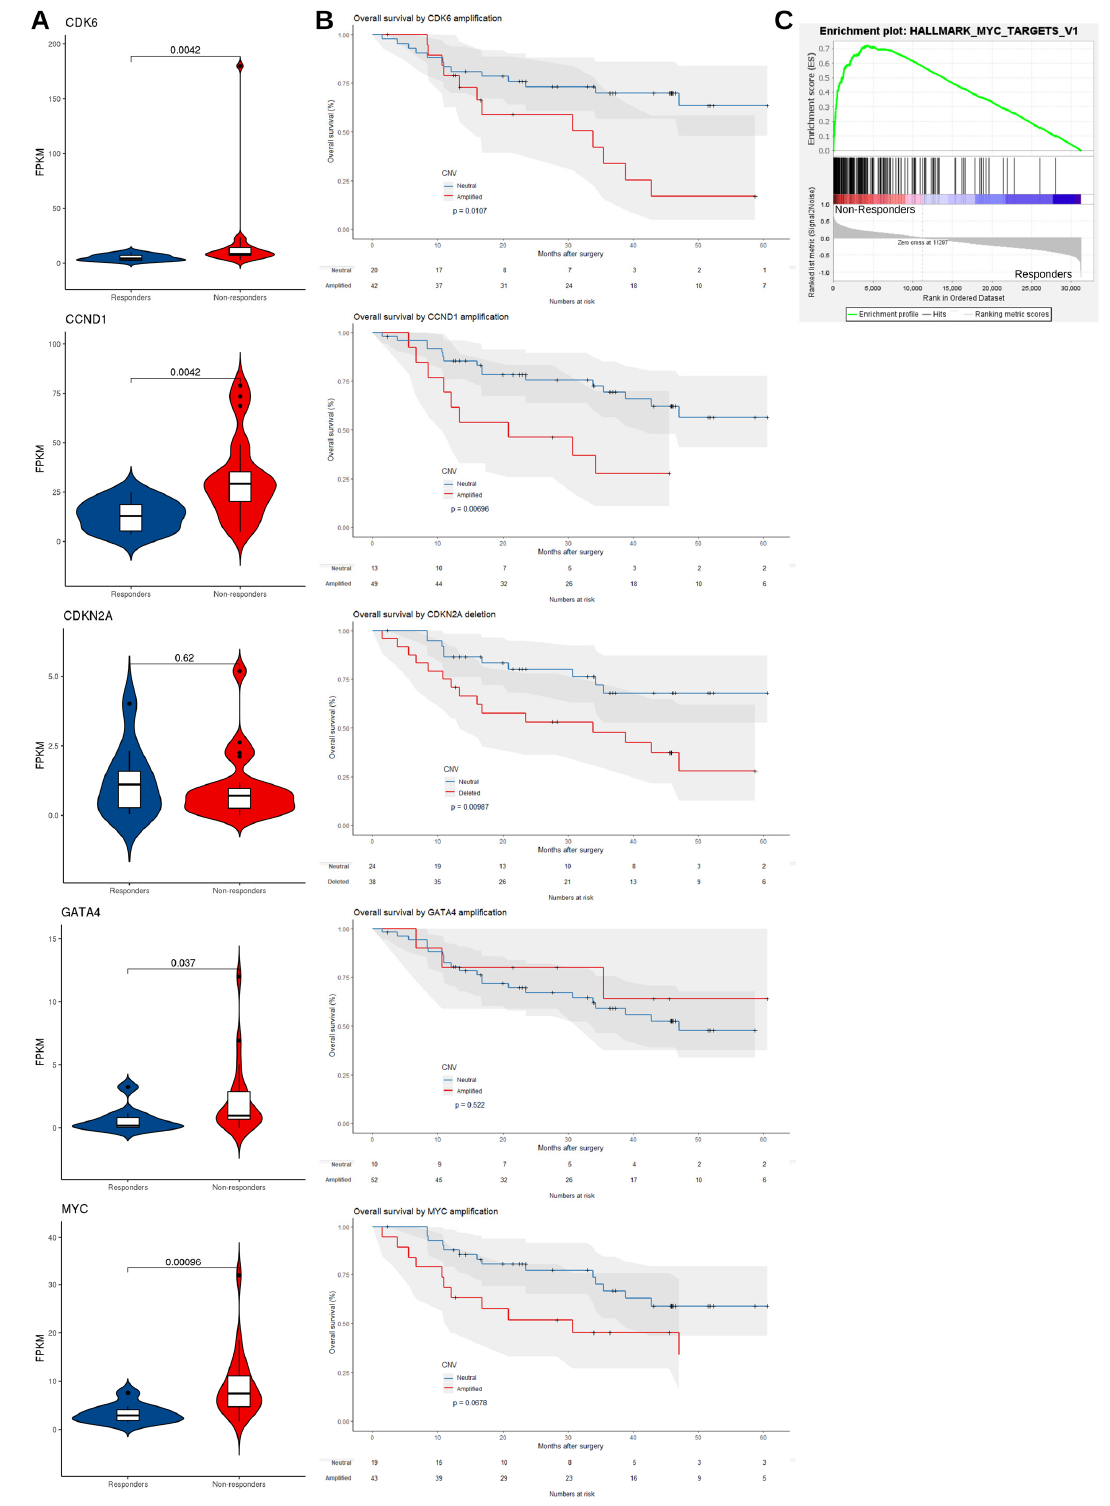
Figure 4. Amplified EAC driver genes are overexpressed in non-responders and copy number alterations associate with poor survival. ( A ) Violin plots comparing mRNA expression levels (FPKM) in matched RNA-Seq data ( n = 9 responders, n = 21 non-responders) for copy number altered EAC driver genes in responders and non-responders. p -values were based on one-tailed Wilcoxon rank-sum test. ( B ) Kaplan–Meier plot comparing overall survival of patients with CDK6 , CCND1, CDKN2A, GATA4 and MYC copy number changes (red) vs. neutral patients (blue). ( C ) Gene Set Enrichment Analysis (GSEA) of MYC target genes in available RNA-Seq data ( n =